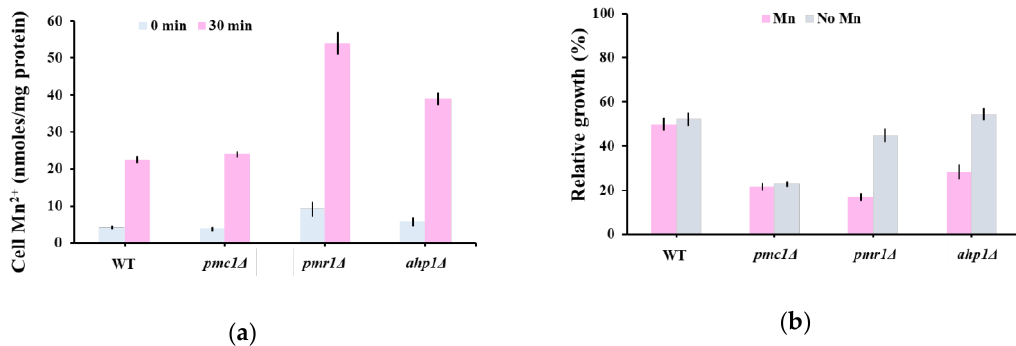
Figure 4. ( a ) Mn 2+ accumulation by mutants hypersensitive to oleandrin. Exponentially growing yeast cells were treated with oleandrin (100 ng/mL) in MMe containing 1 μM MnCl 2 and samples were collected after 20 min for Mn 2+ assay. ( b ) Effect of Mn 2+ depletion on oleandrin toxicity. Cells were incubated (30 °C, 200 rpm) in liquid MMe containing 1 μM MnCl 2 (Mn) or Mn 2+ -depleted (No Mn) in the presence of 100 ng/mL oleandrin. Cell growth was measured spectrophotometrically (OD6 00 ) and expressed relatively to growth under the same conditions, but in the absence of oleandrin.